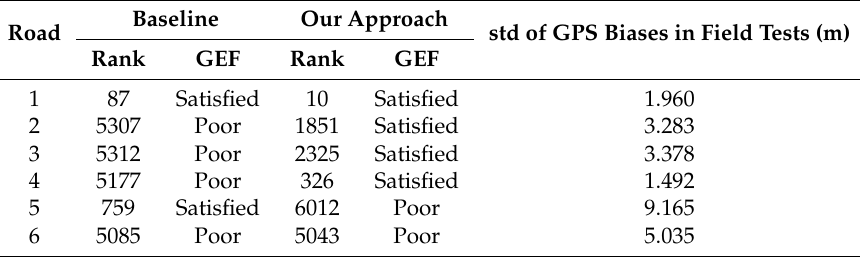
Table 3. Field tests results. GEF, GPS environment